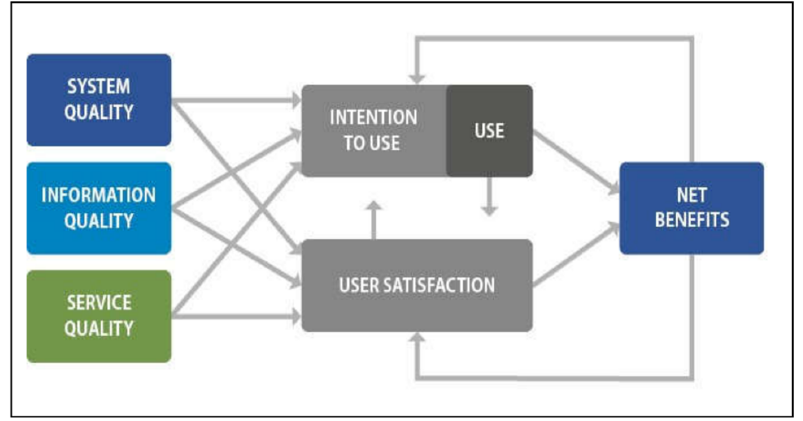
Figure 1. The Delone and Mclean model.